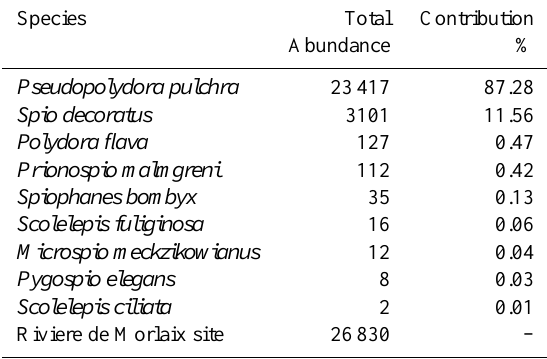
Table 4. List of most abundant Spionid species and contribution to total spionid abundance for the RM